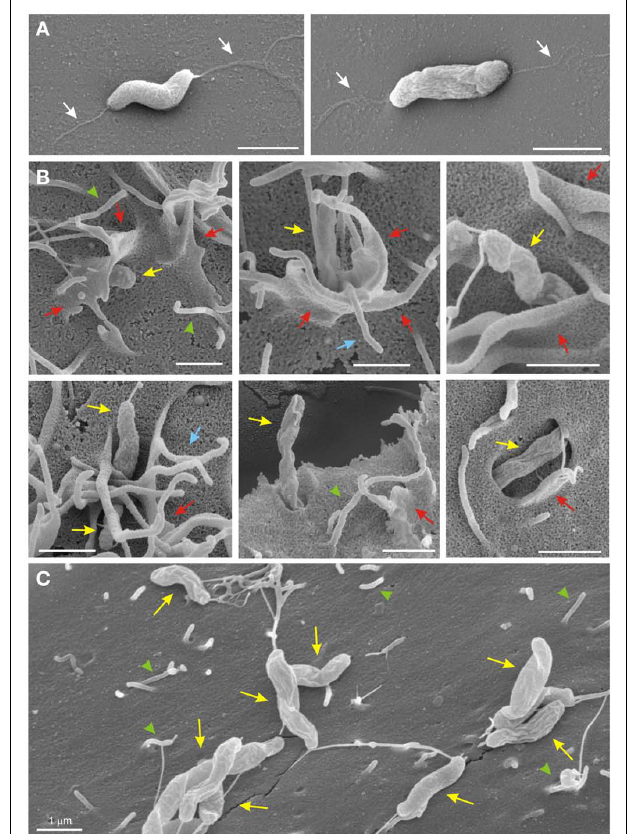
FIGURE 3 | High resolution field emission scanning electron microscopy of C. jejuni invasion. (A) C. jejuni strains have single bipolar flagella (white arrows). (B) C. jejuni 81–176 infected for 4–6h were able to induce their entry into theWT fibroblast target cells and were regularly associated with membrane ruffles (red arrows), filopodia-like structures (blue arrows) as well as elongated microspikes (green arrowheads). Invading bacteria were also marked (yellow arrows). (C) Infection of GD25 knockout cells withWT C. jejuni 81–176 for 6h also revealed bacterial attachment, but membrane dynamics or invasion were not induced. Similar results were observed for the infected Fibronectin-deficient and FAK-deficient cells (data not